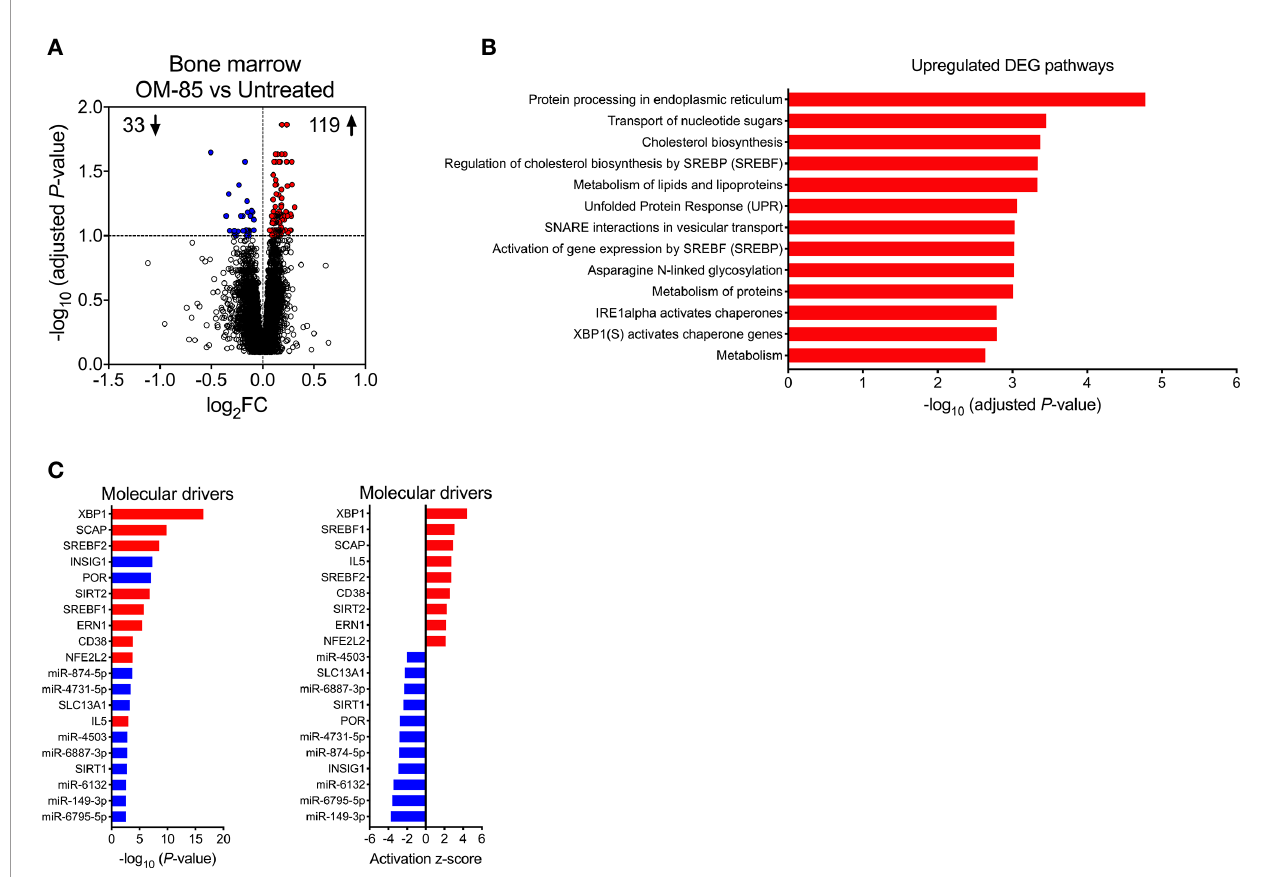
FIGURE 3 | Maternal OM-85-induced changes in fetal bone marrow gene expression pro fi les. (A) DEG within fBM comparing fetuses from OM-85-treated and untreated mothers. DEG are summarized as a volcano plot showing data along axes of statistical signi fi cance (-log 10 adjusted P -value) and differential expression magnitude (log 2 fold change) for n = 16 individual animals per group collected from n = 7 independent experiments. Dashed horizontal lines indicate a False Discovery Rate (FDR) adjusted P -value < 0.1. Genes shown in red were upregulated and those shown in blue were downregulated. (B) Top biological pathways associated with upregulated DEG within fBM comparing fetuses from OM-85-treated and untreated mothers. (C) Activated (red) and inhibited (blue) molecular drivers of the differential expression patterns were identi fi ed using Upstream Regulator